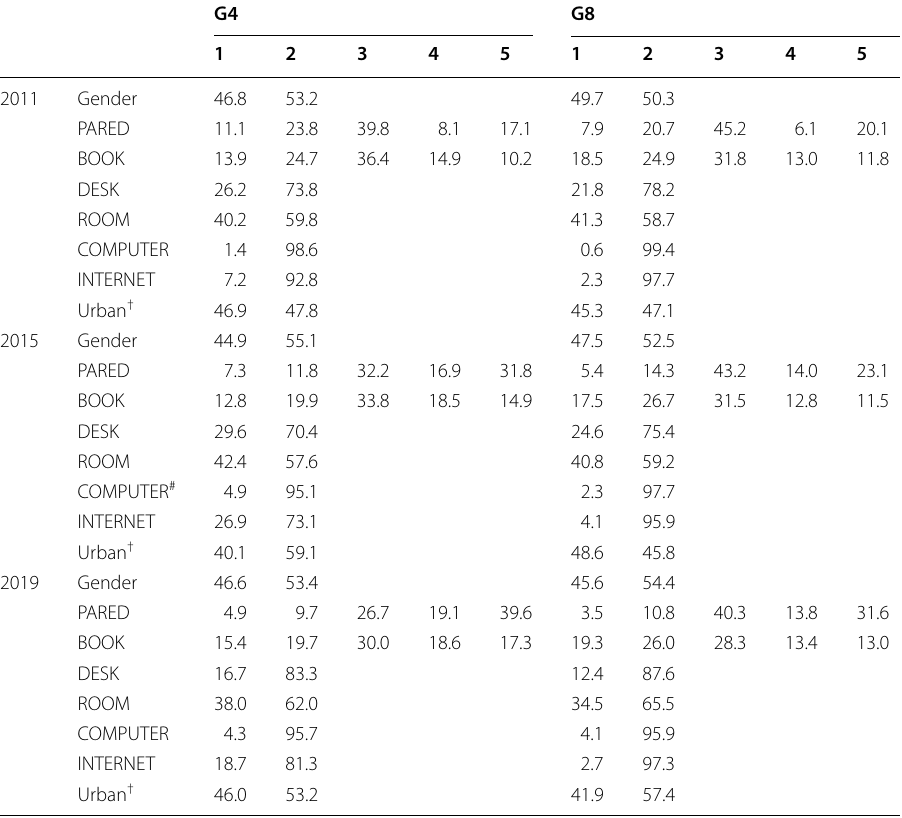
Table 4 Percentage of categorical variables (%) for TIMSS 2011 to